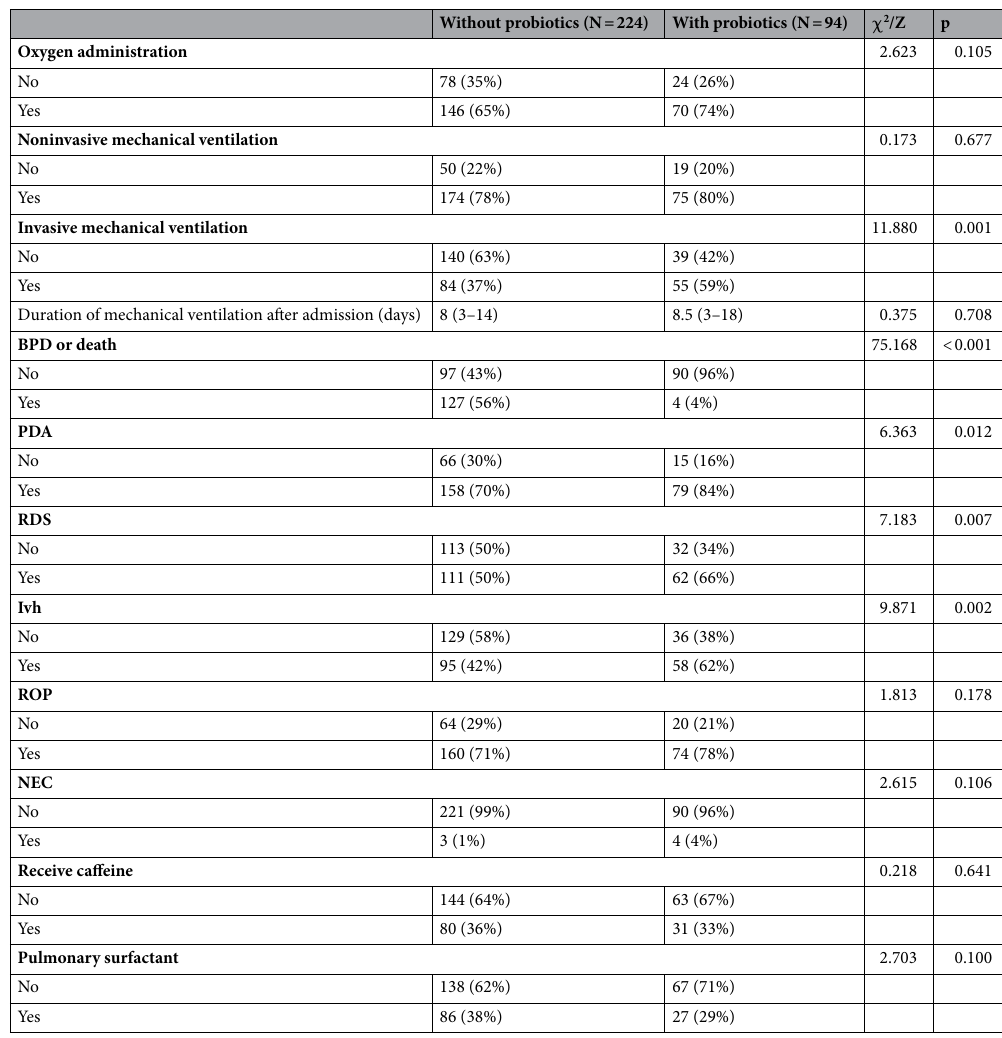
Table 2. Clinicopathological characteristics of study subjects.